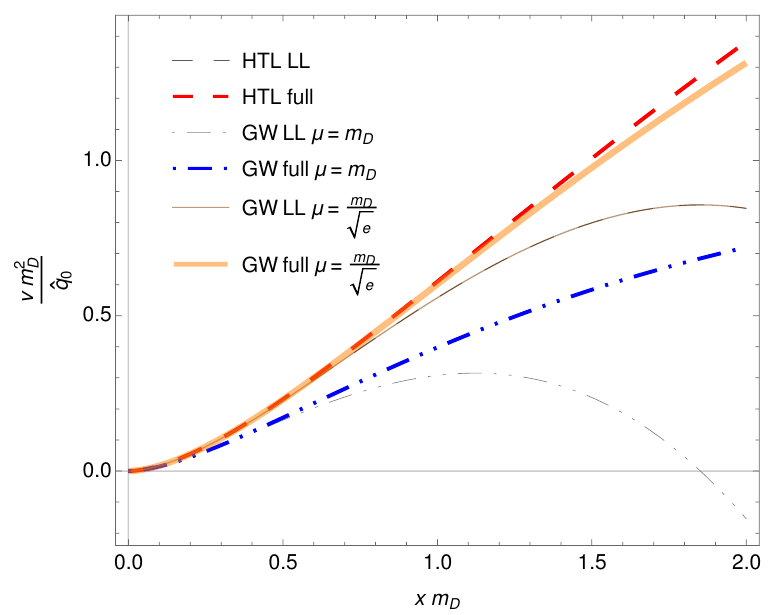
Figure 1 . Plot of the potential v for the HTL and GW models. Here we have normalized the 2 potential to m and the dipole size j x j is given in units of the Debye mass. The dashed curves D ^ q 0 correspond to the HTL model, the dash-dotted lines give the GW model potential when (cid:22) GW = m D and the full lines correspond to the GW model solution in the Leading Logarithmic (LL) approximation (full thin curve) and for the full potential (full grosser line) when one makes use of the matching proposed in (2.11). The LL curves for both the HTL and GW model show that this approximation breaks down when j x j (cid:24) 1 , as m D